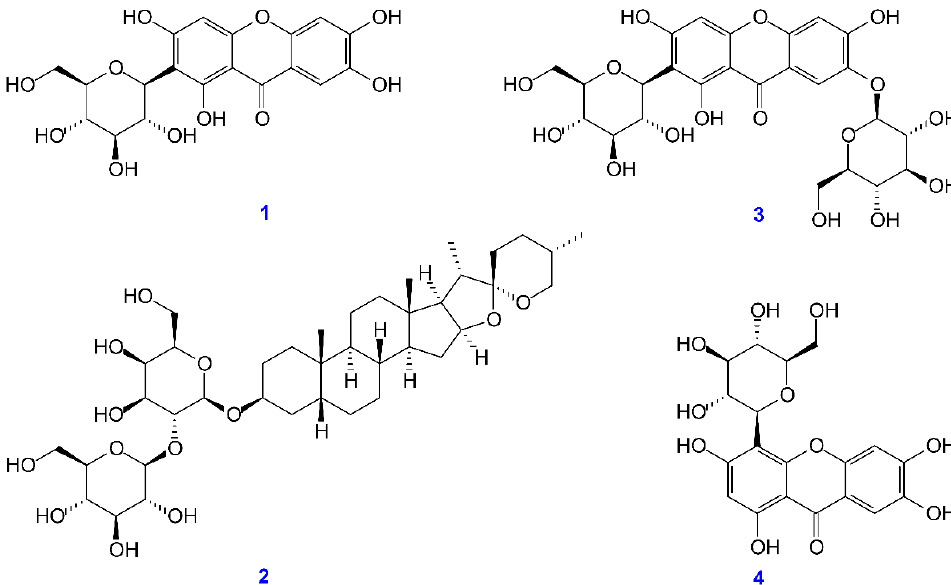
Figure 4. Chemical structures of mangiferin ( 1 ), timosaponin A-III ( 2 ), neomangiferin ( 3 ), and isomangiferin ( 4 ) from Anemarrhena asphodeloides . Table 6. The antioxidant activities of isolated components from Anemarrhena asphodeloides deter- mined with DPPH, ABTS, superoxide radical scavenging, and ferric-reducing antioxidant power (FRAP) assays.